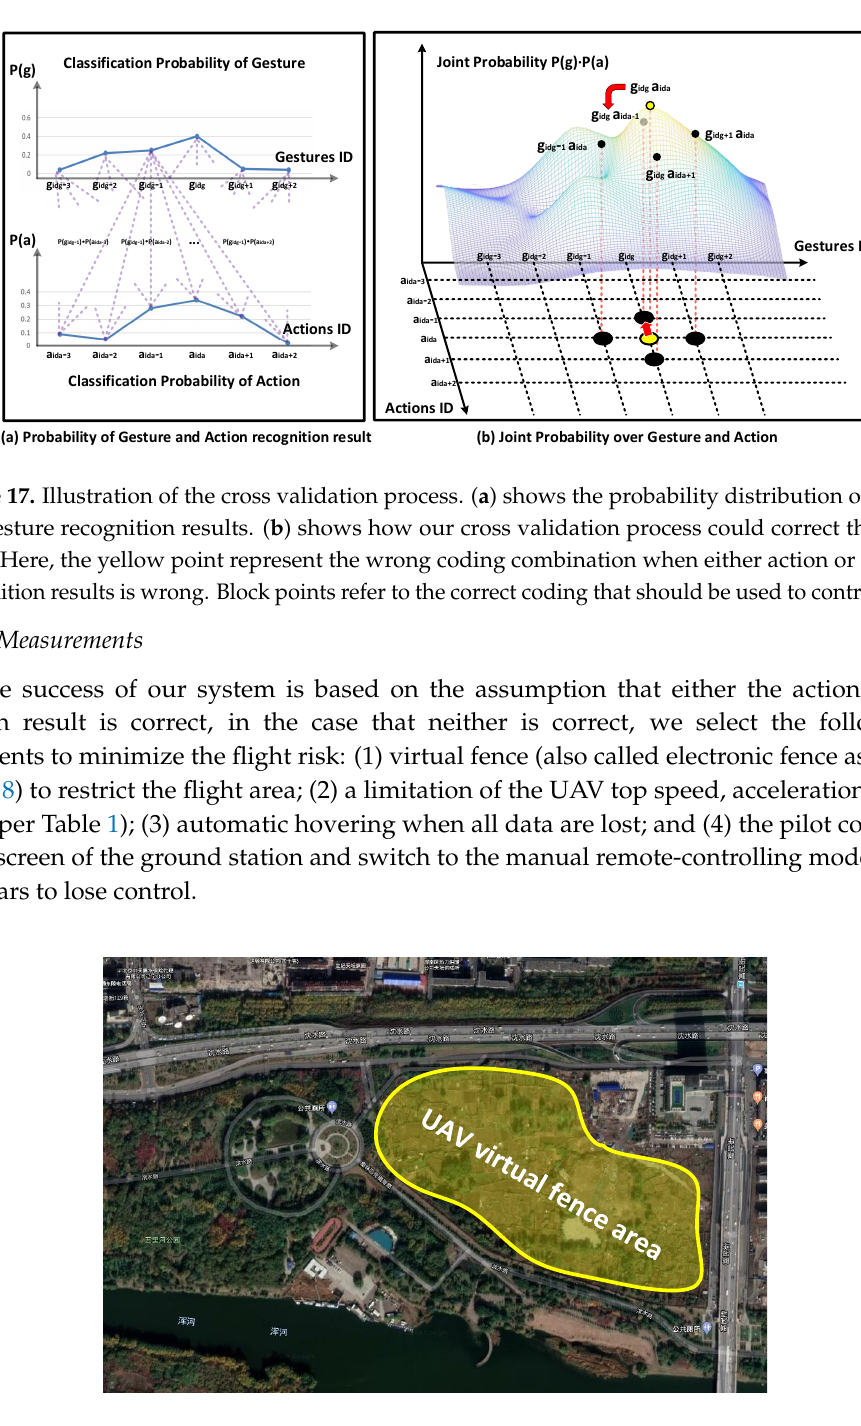
Figure 18. Virtual fence to restrict the flight